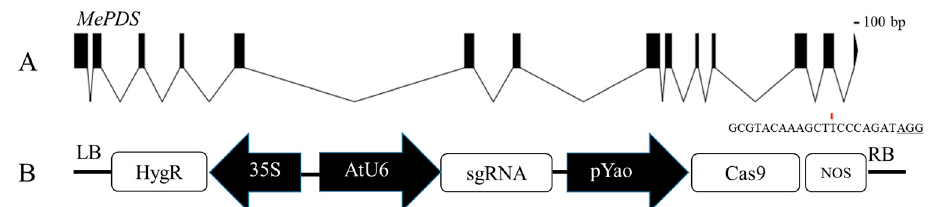
Figure 7. Target site of the MePDS gene and the T-DNA of the pYAO :hSpCas9-gRNA binary vector. ( A ) Structural organization of the MePDS gene. Exons and introns are shown as boxes and lines, respectively. ( B ) Schematic of the CRISPR/Cas9 binary vector pYAO :hSpCas9-MePDS-gRNA for MePDS gene editing through Agrobacterium -mediated transformation.